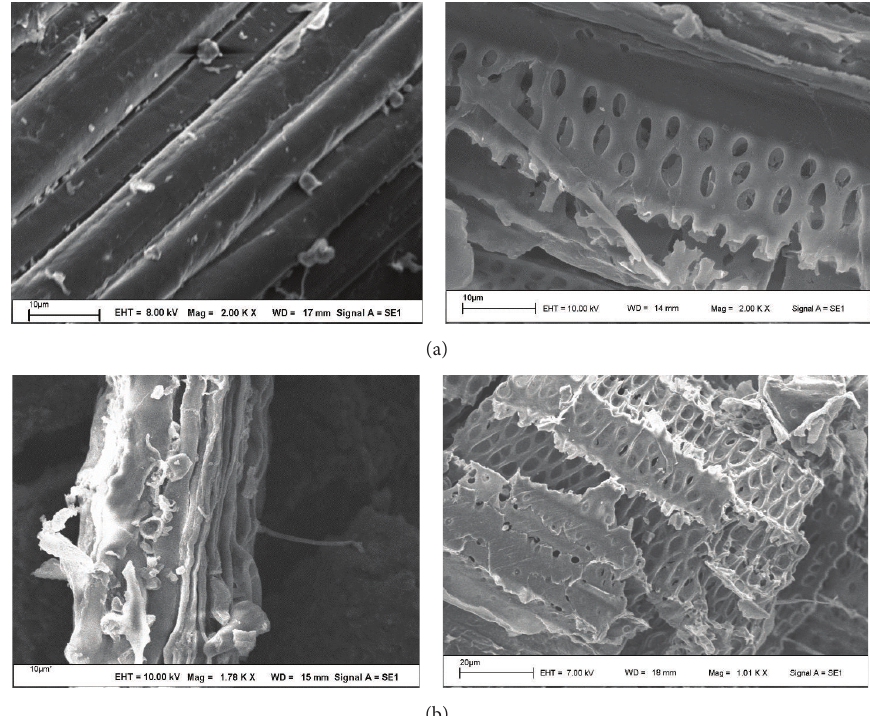
Figure 7: SEM analysis of biomass: (a) before and after acid treatment of bagasse and (b) before and after acid treatment of spent citronella